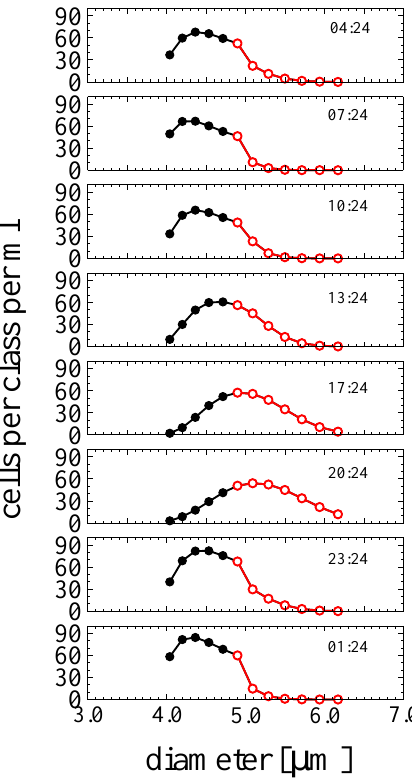
Fig. 5. Model output for cell concentrations for each class plotted from top to bottom every three hours for day of the year 196 (results obtained for the median of the optimal parameters and n = 1 . 06). Black filled circles: newborn cells; red open circles: dividing cells. Numbers inside plots indicate the time of the day in UTM.